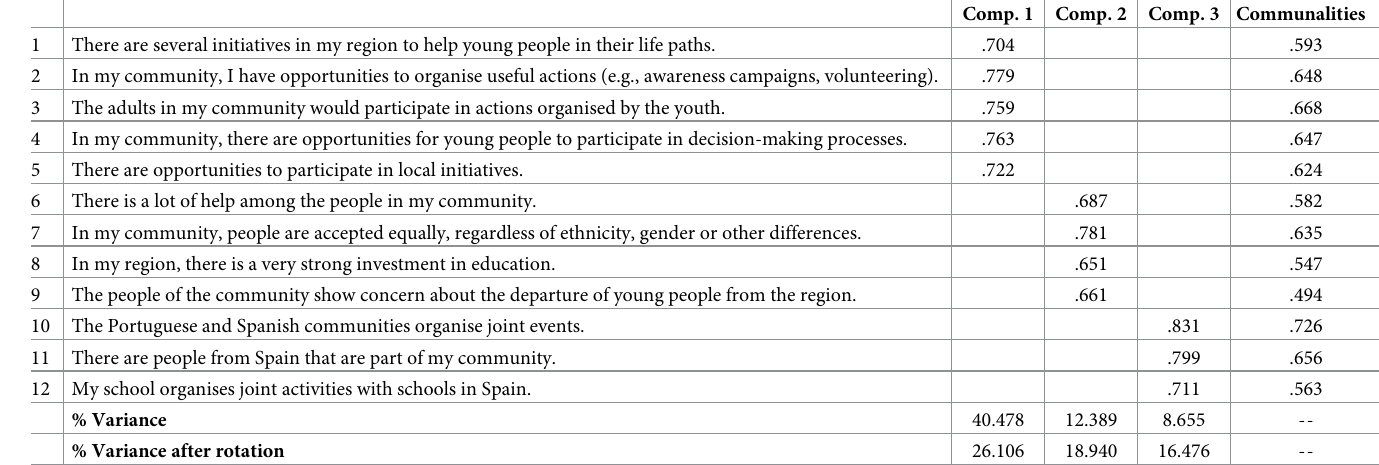
Table 2. Results of principal component analysis—CRS-Y Scale (random sample a; n = 1828).